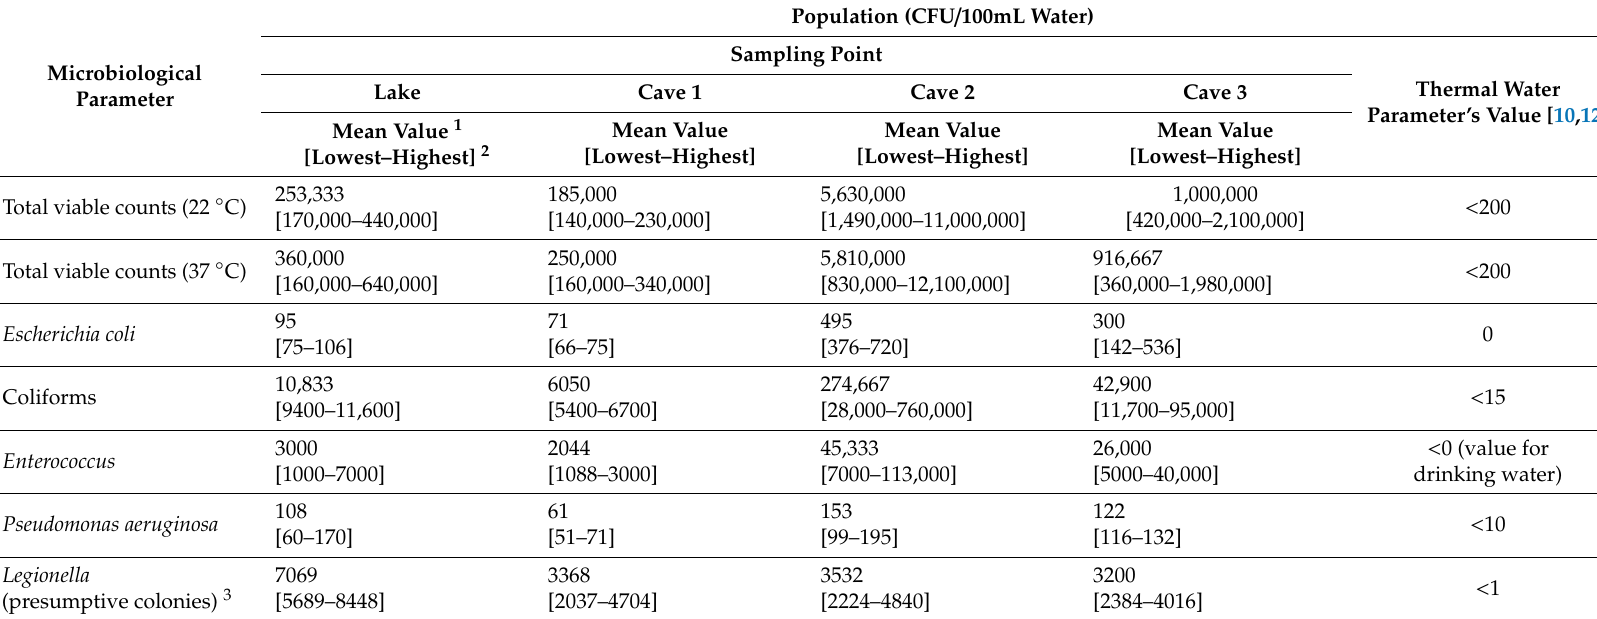
Table 1. Population of microbiological parameters enumerated in thermal waters of Lake, Cave 1, Cave 2, and Cave 3 of Kaiafas thermal spring Anigrides Nymphes in